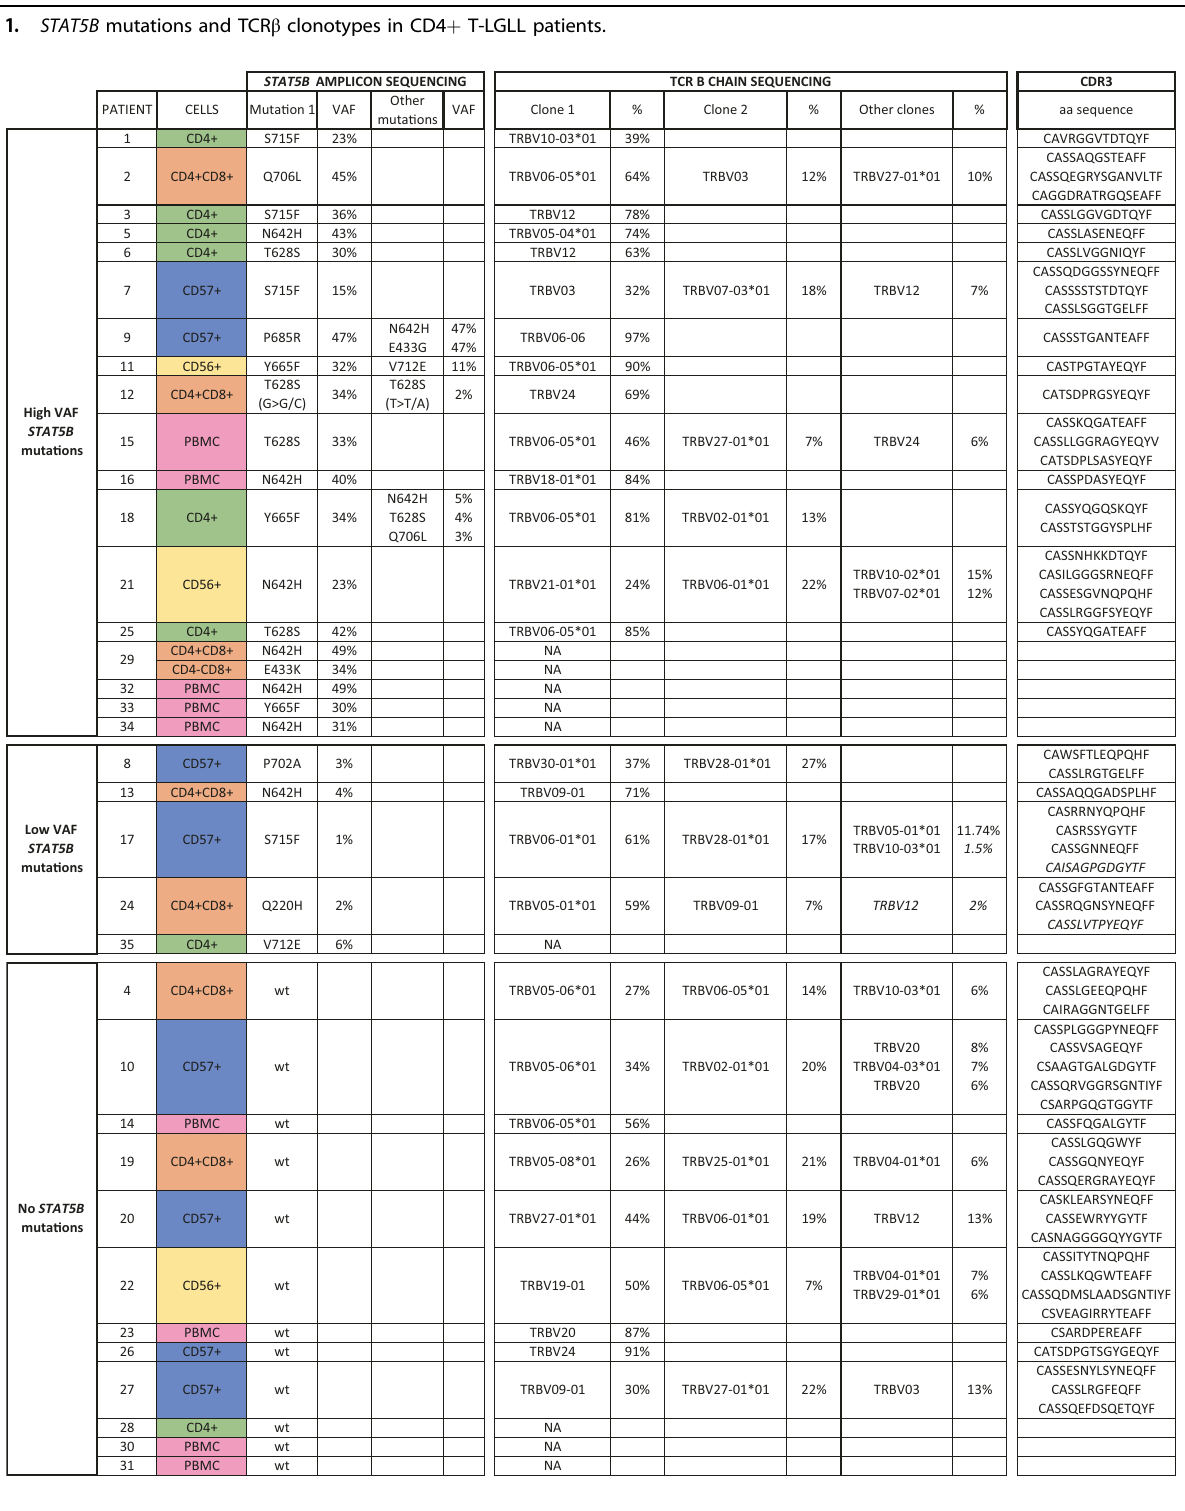
ANtwCMBP03 ANtwCMBP13 STAT5B mutation status, type of the STAT5B mutation and TCR V β chain sequences (>5%) with their relative percentage (%) are given for each patient. For patients #17 and #24, two additional clones <5% are reported considering the putative match with the low STAT5B mutation VAF (in italics). The CDR3 amino acid sequences are listed according to the % of the V β expansions (from the highest to the lowest). Color codes the cell of origin used in the sequencing: green, CD4 + sorted cells; orange, CD4 + CD8 + sorted cells; blue, CD57 + sorted LGLs; yellow, CD56 + sorted LGLs; pink, PBMC. VAF variant allele frequency, wt wild-type, PBMC peripheral blood mononuclear